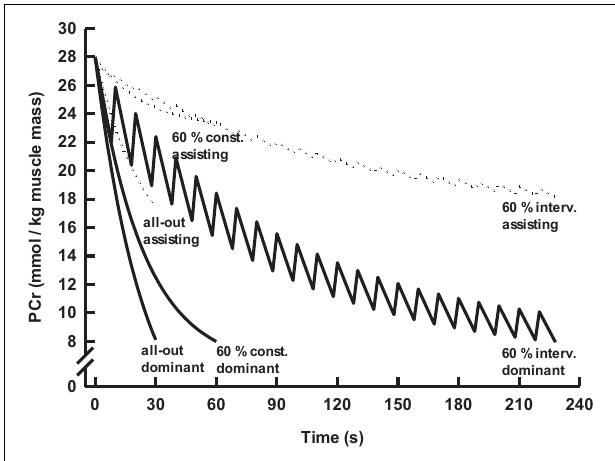
FIGURE 4 | Phosphocreatine decrease in the dominantly stressed and assisting muscles during the muscle endurance